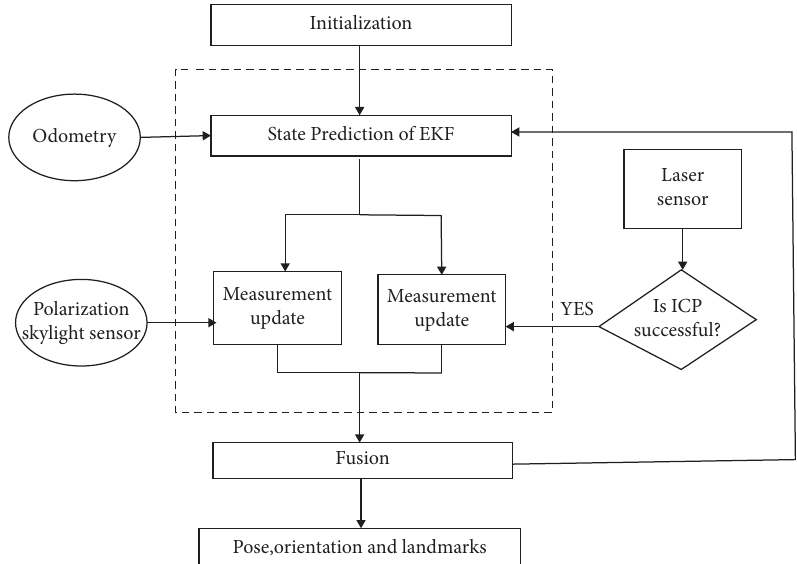
Figure 20: Te multisensor fusion V-SLAM.